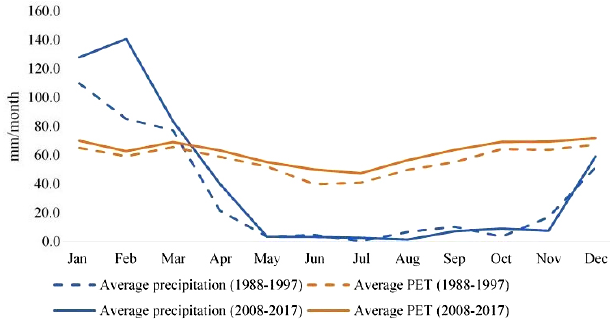
Fig. 2 . Monthly average precipitation and potential evapotranspiration (PET) for the periods of 1988 to 1997 and 2008 to 2017 in the Lari